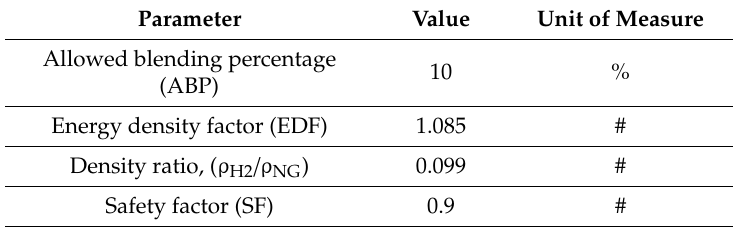
Table 7. Parameters used in the calculation of corrected hydrogen blending threshold.